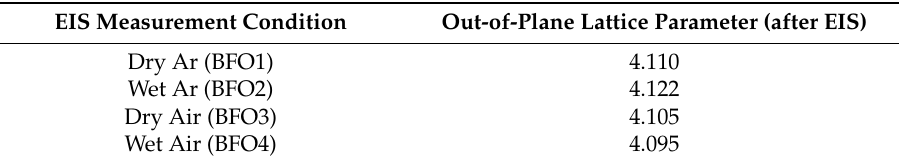
Table 3. Lattice parameters c out for samples BFO1-4 after EIS measurement ( ± 0.001